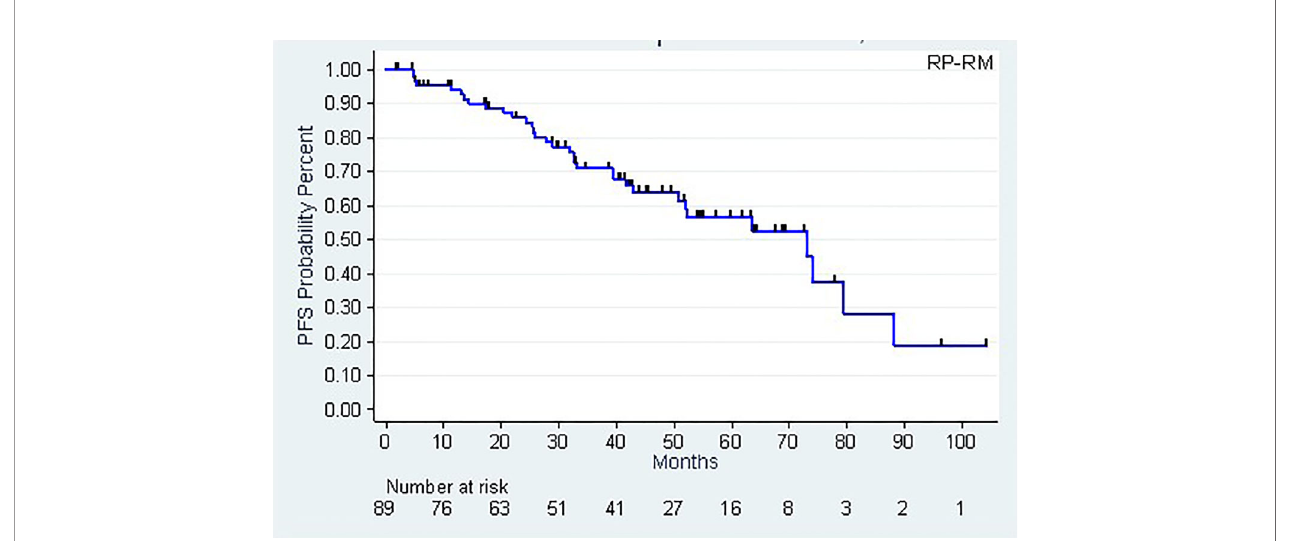
FIGURE 3 | Biochemical progression-free survival (PSA nadir + 0.5 ng/mL).